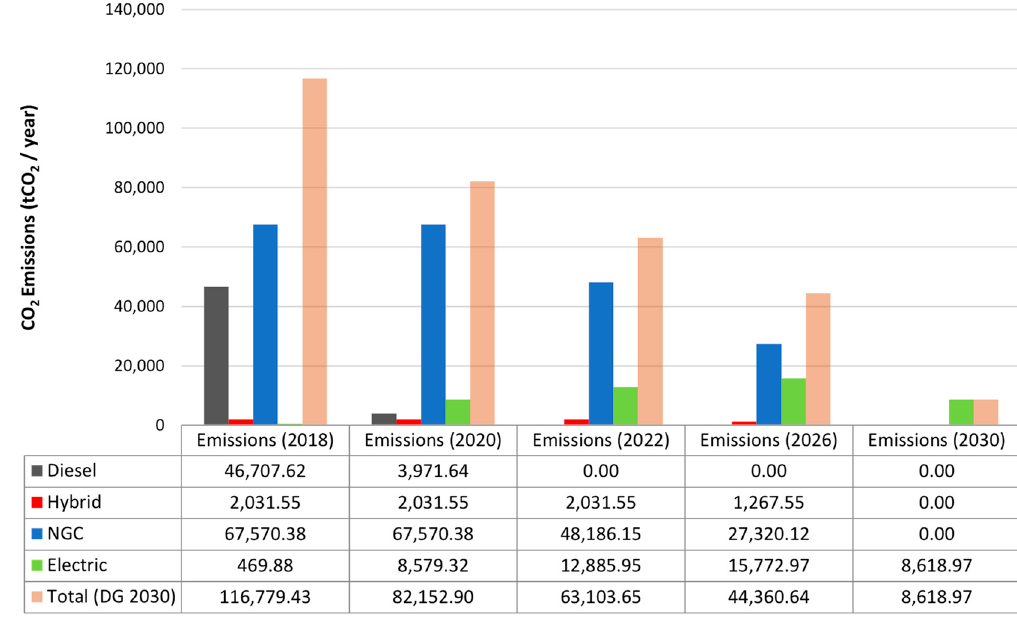
Figure 19. Comparison of the estimated CO 2 emissions for different bus fleet phases substitution with the Spanish electricity mix DG2030.